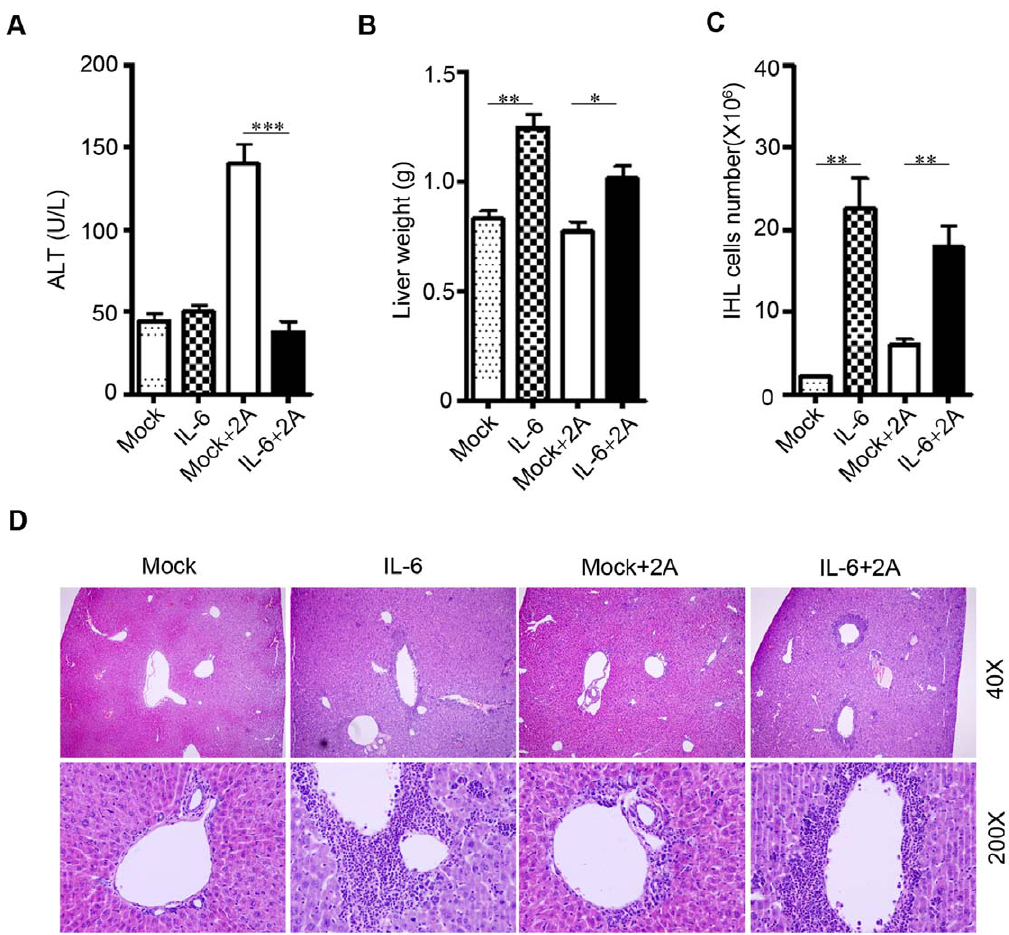
Figure 1. Ectopic IL-6 expression in vivo leads to enhanced intrahepatic leukocytes infiltration but protect T cell-mediated liver injury. C57BL/6 mice were hydrodynamic injected with pcDNA-IL6 plasmid or mock control plasmid at day 0. At day 2, mice were further injected i.p. with 100 m g 2A antibody or or control antibody (RIg).The mice were sacrificed at day 12, and serum ALT levels (A), liver weight (B) and the number of intrahepatic leukocytes (C) were measured. (D) At day12, the livers were fixed and stained with H&E. Representative images from 3–4 mice in each group were shown. Three experiments were performed with similar results. *P , 0.05, **P , 0.01, ***P , 0.001 in comparison with groups as indicated.